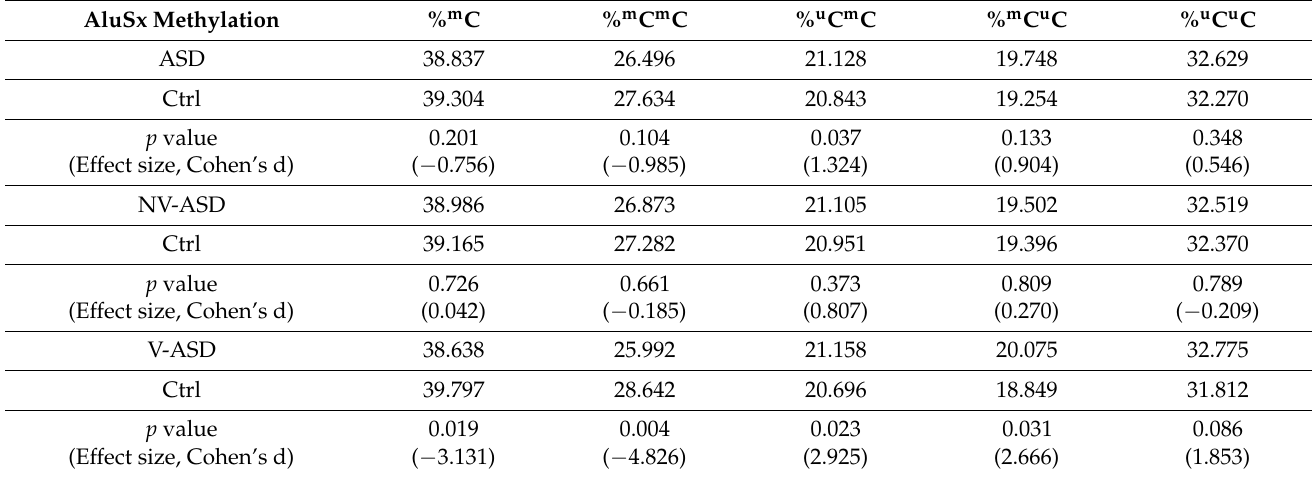
Table 4. COBRA-derived percentages of AluSx methylation levels and patterns in the prefrontal cortex of ASD individuals and sex- and age-matched unaffected